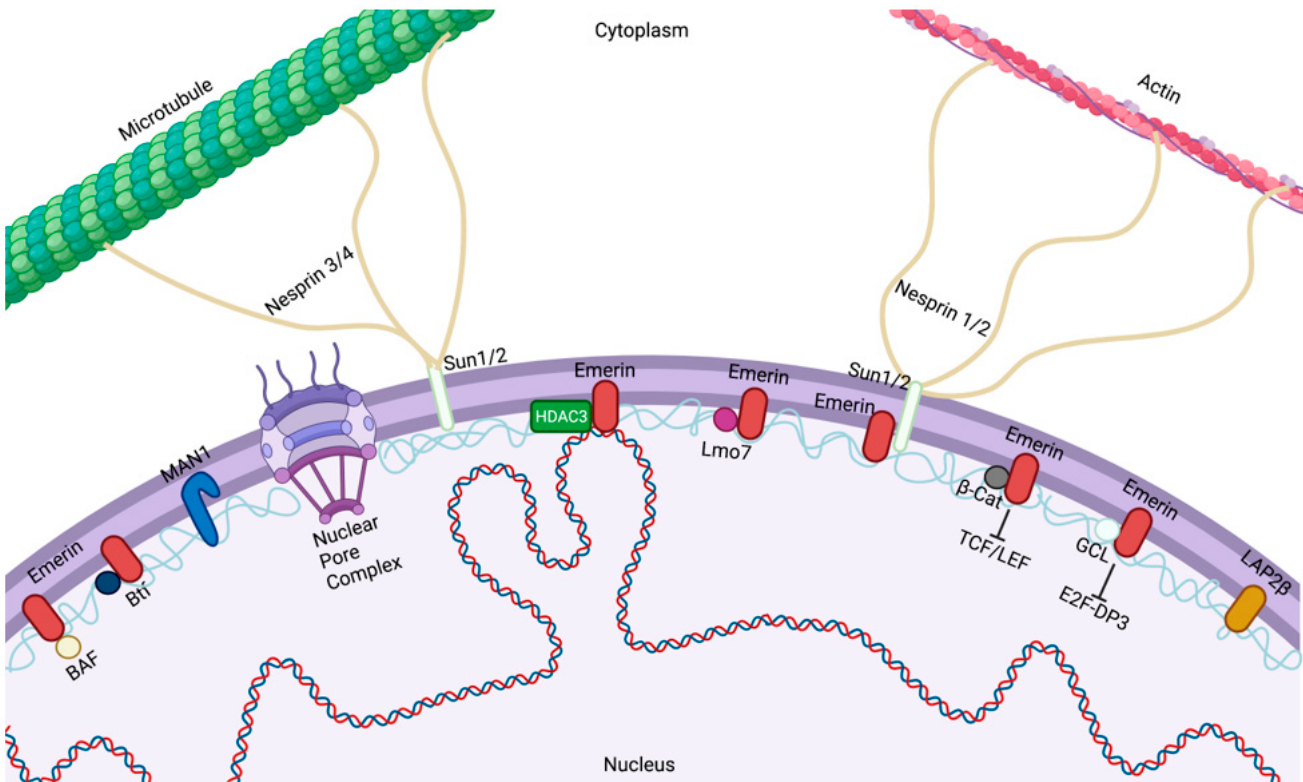
Figure 1. The nuclear envelope. Emerin, Lap2 β , and MAN1 bind to lamins at the inner nuclear membrane of the nuclear envelope, where they perform diverse functions within the nucleus. Emerin regulates gene expression by regulating chromatin architecture through binding to HDAC3 and transcription factors (GCL, β -catenin, Lmo7, and Btf) and altering signaling pathways. Created with BioRender.com.